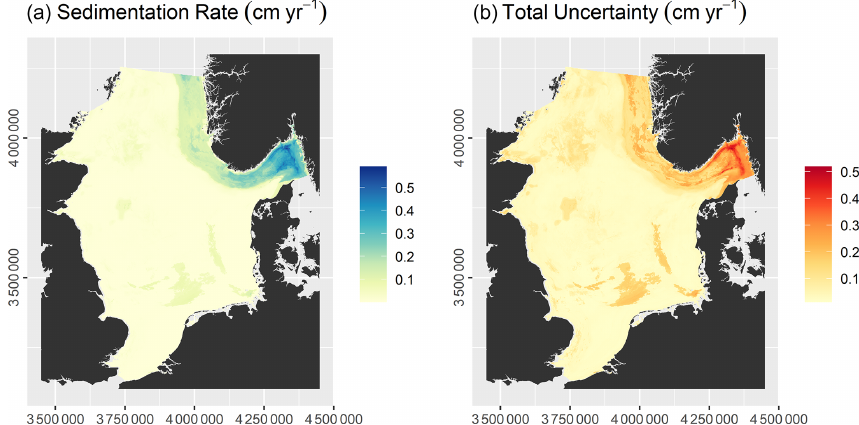
Figure 4. Predicted sedimentation rate (a) and associated uncertainty in the predictions (b)